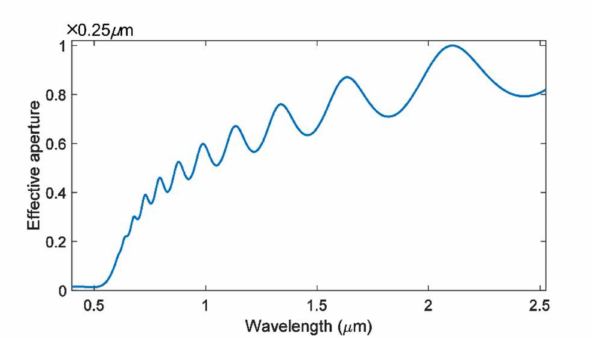
Figure A1. Effective-aperture spectrum for the direct coupling of the free space and MIM waveguide, without nanoantenna localized at the